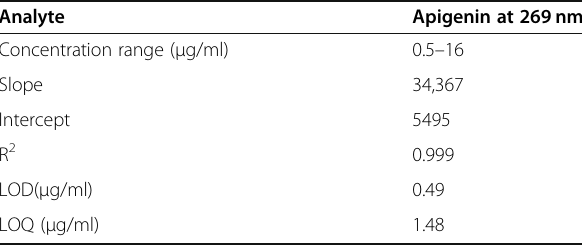
Table 2 Results of linearity and regression analysis of apigenin